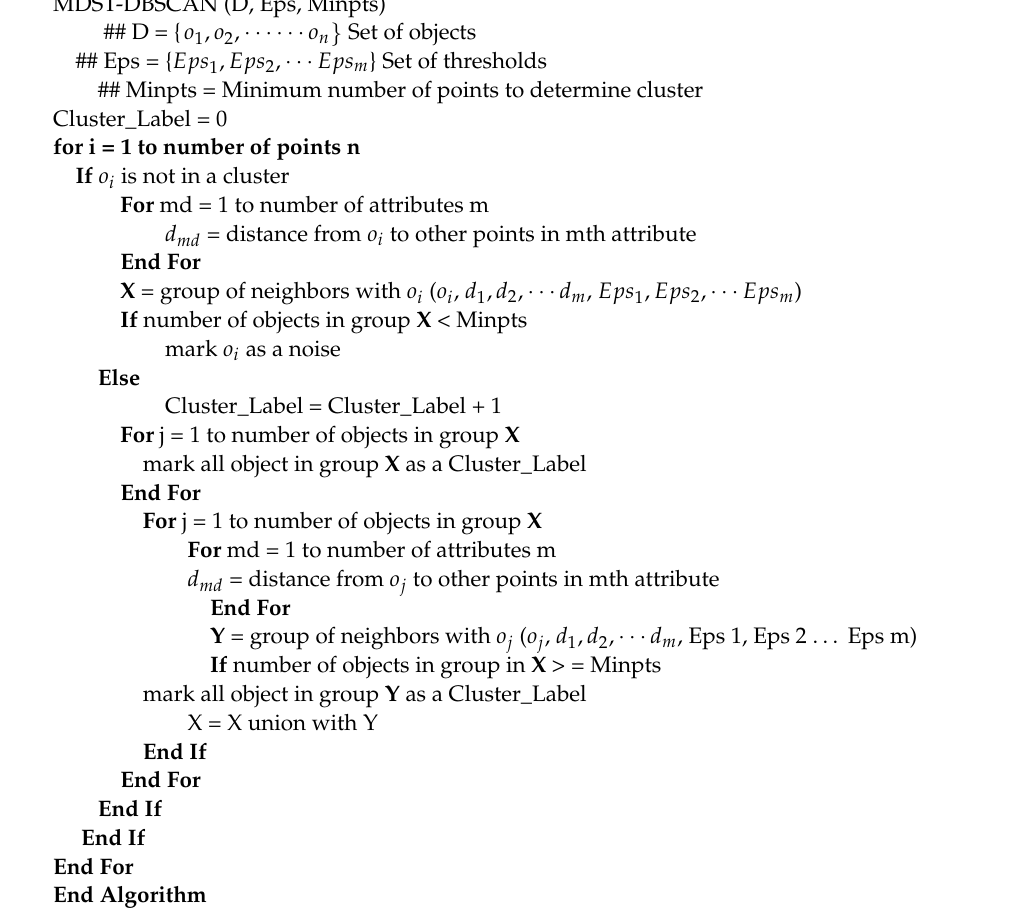
Algorithm 1 MDST-DBSCAN